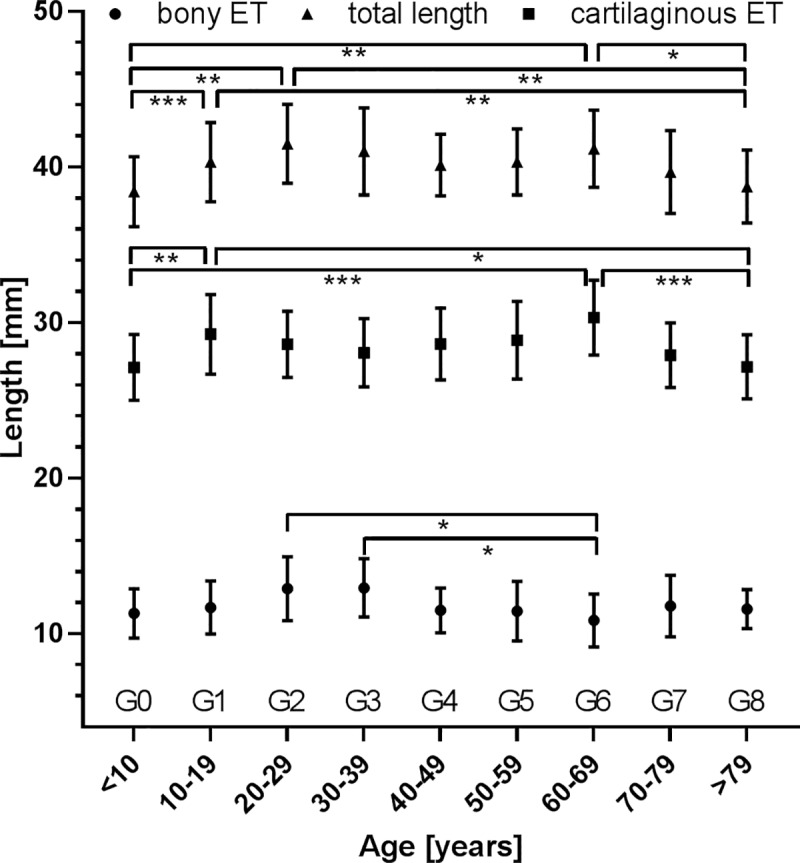
Total length of the ET (▲) and lengths of cartilaginous (■) and bony parts (●) of all patients without pre-existing conditions as sorted according to the age groups.Presented are mean values ± standard deviations (SD). * p < 0.05; ** p < 0.01; *** p < 0.001.